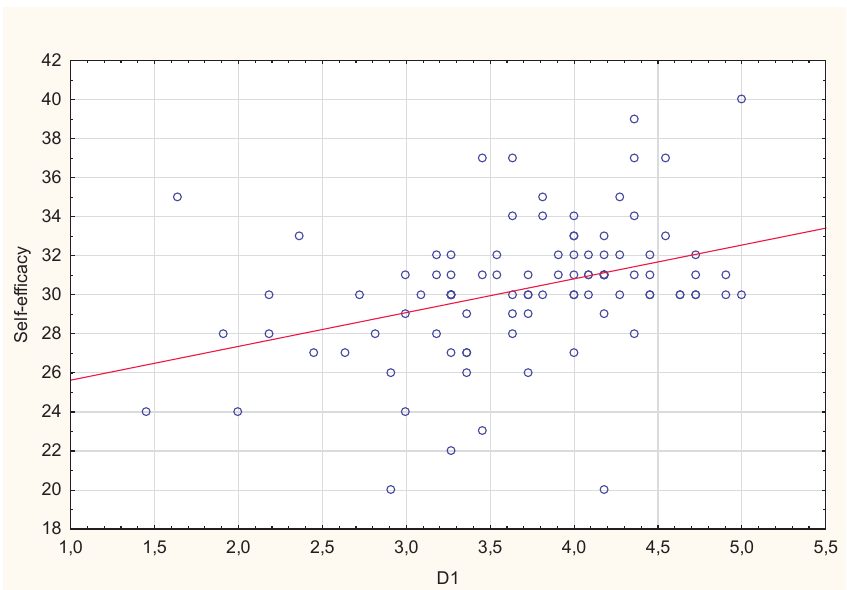
Figure 3. (cid:55)(cid:75)(cid:72)(cid:3)(cid:86)(cid:70)(cid:68)(cid:87)(cid:87)(cid:72)(cid:85)(cid:3)(cid:71)(cid:76)(cid:68)(cid:74)(cid:85)(cid:68)(cid:80)(cid:3)(cid:178)(cid:3)(cid:54)(cid:72)(cid:79)(cid:73)(cid:16)(cid:72)(cid:73)(cid:192)(cid:70)(cid:68)(cid:70)(cid:92)(cid:3)(cid:87)(cid:82)(cid:3)(cid:83)(cid:75)(cid:92)(cid:86)(cid:76)(cid:70)(cid:68)(cid:79)(cid:3)(cid:90)(cid:72)(cid:79)(cid:79)(cid:16)(cid:69)(cid:72)(cid:76)(cid:81)(cid:74)(cid:3)(cid:11)(cid:39)(cid:20)(cid:12)(cid:3)(cid:73)(cid:82)(cid:85)(cid:3)(cid:87)(cid:75)(cid:72)(cid:3)(cid:68)(cid:81)(cid:68)(cid:79)(cid:92)(cid:93)(cid:72)(cid:71)(cid:3)